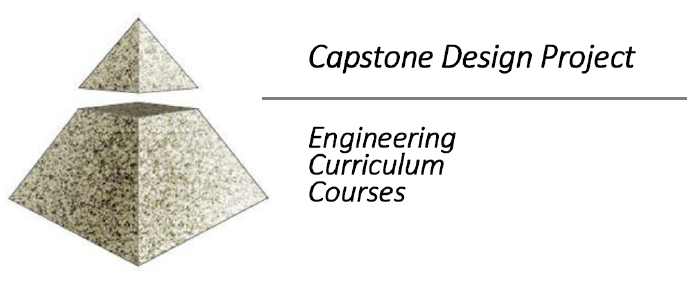
Fig. 1. Capstone design project acts a cap for the engineering curriculum